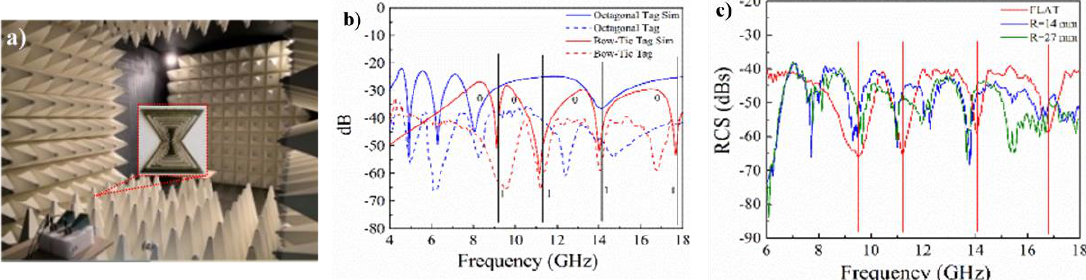
Figure 3. Our developed chipless RFID tags [16], ( a ) experimental set-up in chamber, ( b ) simulated and measured RCS responses of octagonal and bow-tie chipless RFID tags, and ( c ) Bending of chipless bow-tie RFID tag with polyethylene terephthalate (PET) substrate at R = 27 mm and R = 14 mm.